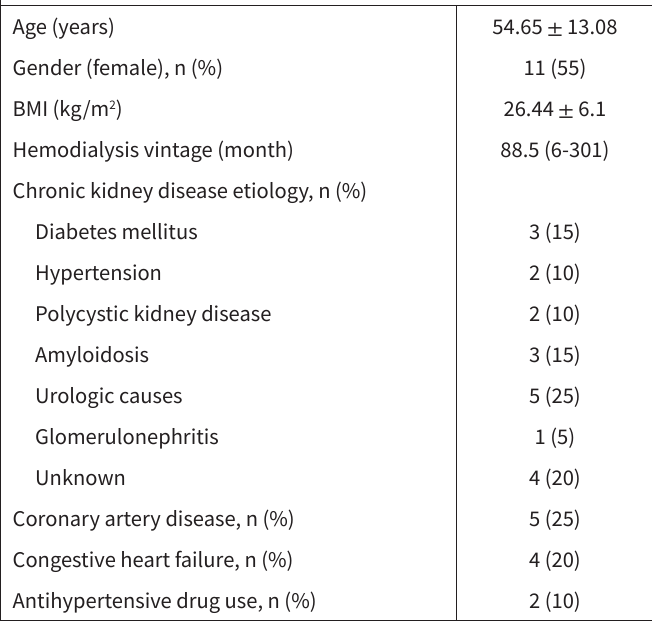
Table 1. Demographic and Clinical Features of the Study Patients